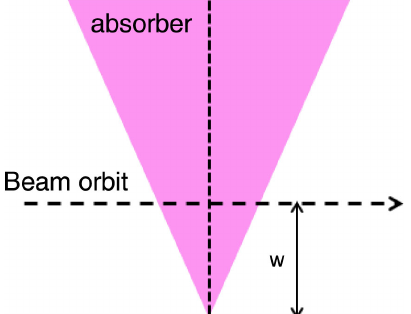
FIG. 6. edge geometry for emittance exchange. With wedges and dispersion, the partition numbers g their sum remains constant [30]. For dispersion D and wedge absorbers with height w from the beam to the wedge apex, the transverse partition function becomes g